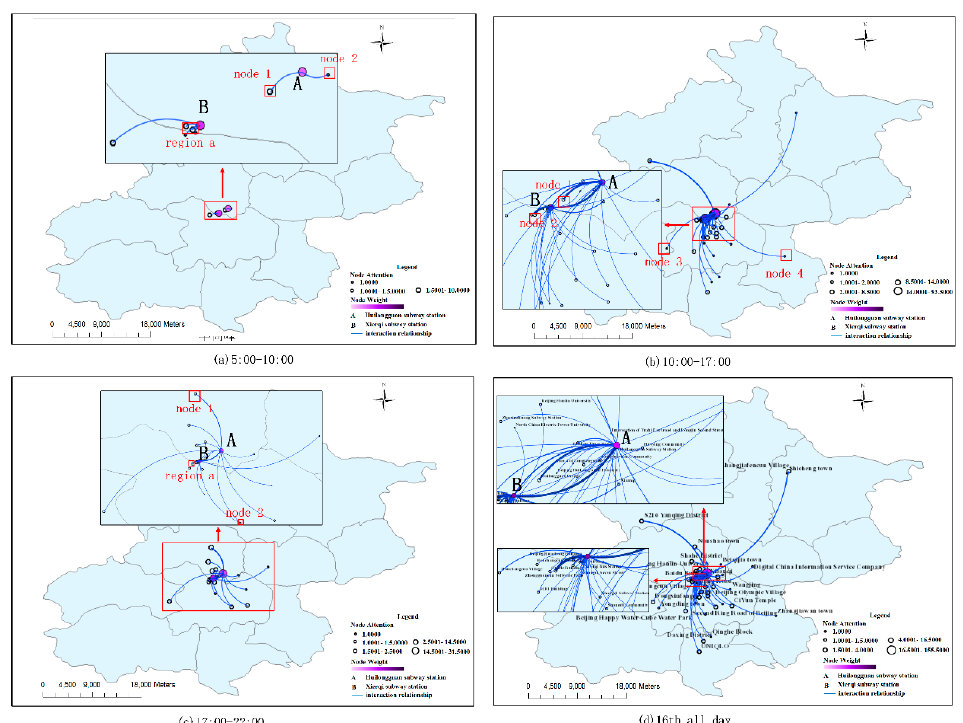
Figure 7. Changes in the spatiotemporal influence of the disaster situation at “Xierqi subway station” and “Huilongguan subway station”. The figure ( a ), ( b ), ( c ) and ( d ) describe the magnitude and distribution of spatial influence of these two nodes in different time periods. Among them, the time period described in figure ( a ) is the morning peak, figure ( c ) is the evening peak, figure ( b ) is the other periods, and figure ( d ) is the whole day on the 16th. The red rectangles in each figure are regions of interest which will be further studied in